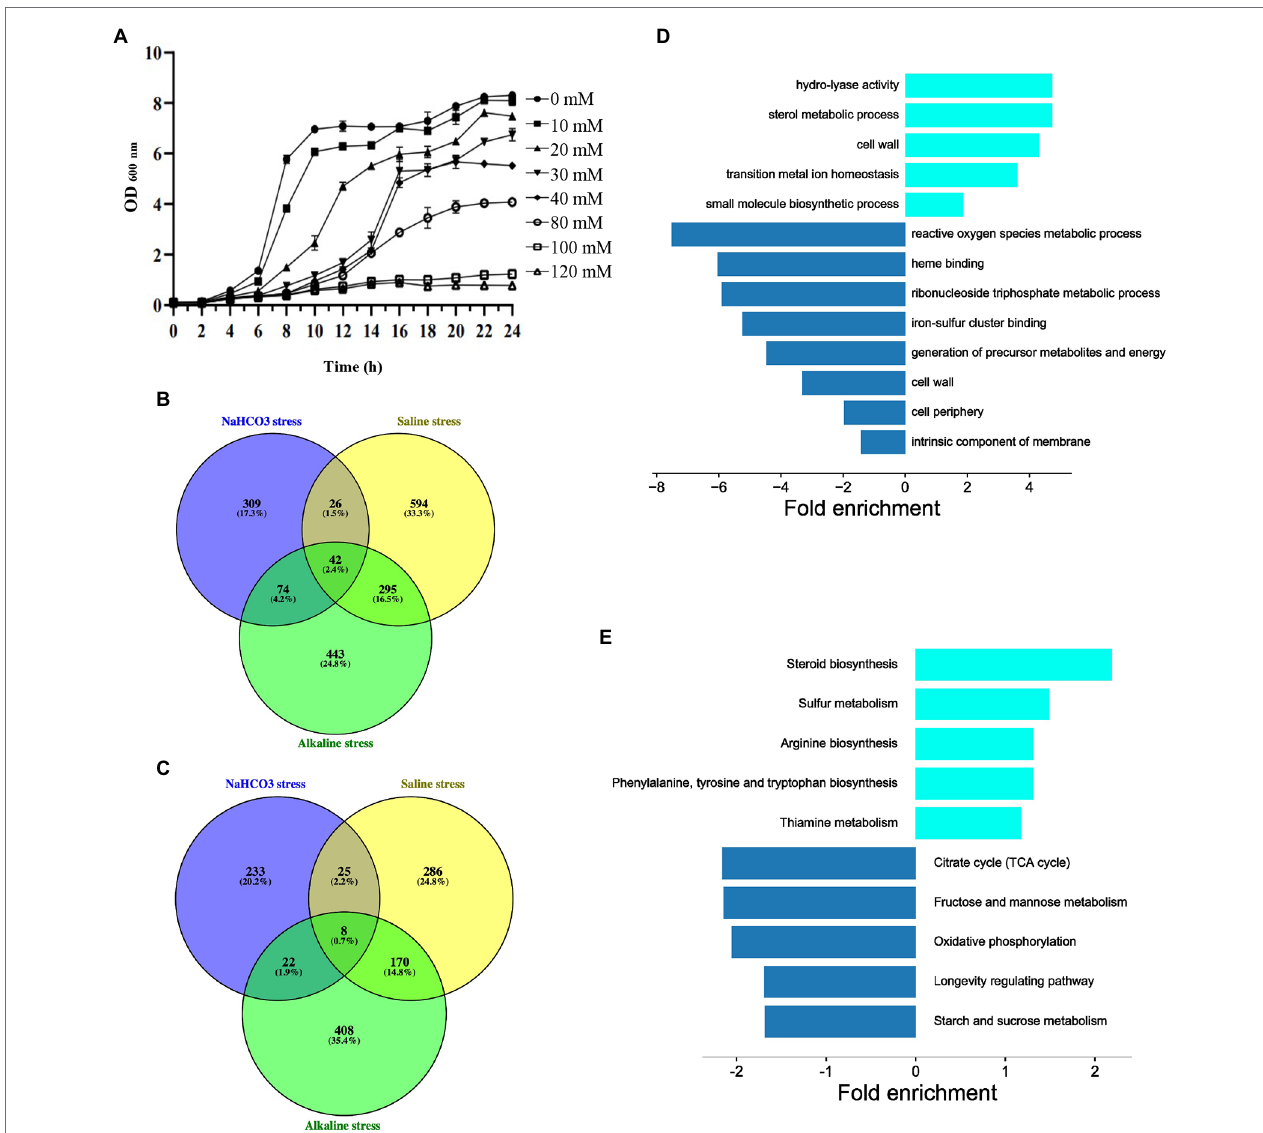
FIGURE 5 | Transcriptional analysis of gene expression under NaHCO 3 treatment. (A) Growth curve of BY4741 under different concentrations of NaHCO 3 . (B) Venn diagram analysis of 451 upregulated genes under NaHCO 3 stress vs. the 854 and 957 genes which also are upregulated under alkaline and saline stress, respectively. (C) Venn diagram analysis of 288 downregulated genes under NaHCO 3 stress vs. the 608 and 489 genes, which are also downregulated under alkaline and saline stress, respectively. (D) GO enrichment analysis of 309 upregulated and 233 downregulated genes that only respond to NaHCO 3 stress. (E) KEGG enrichment analysis of 309 upregulated and 233 downregulated genes that only respond to NaHCO 3